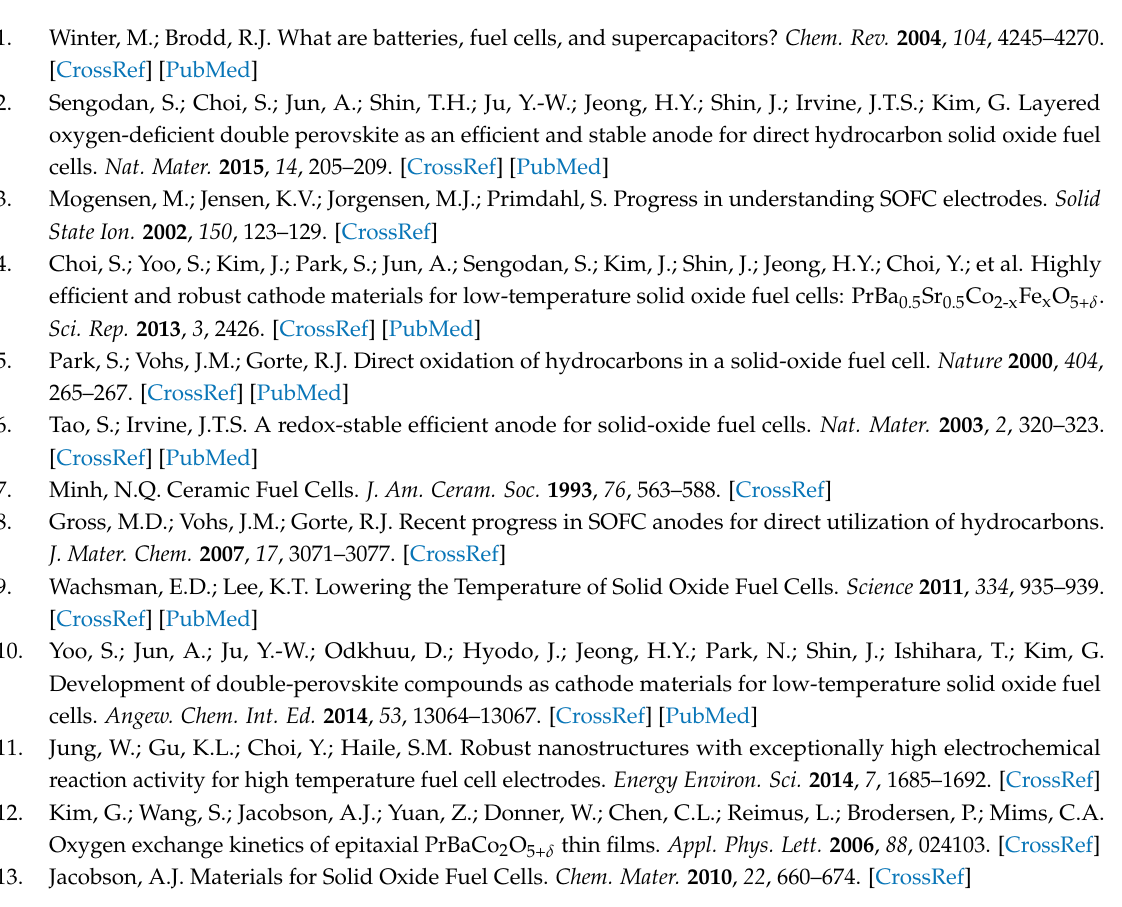
s1, Figure S1: The high-resolution transmission electron microscopy (HRTEM) images of (a) PBCO, (b) PBCSc, and (c) SP-PBCSc, Figure S2: Impedance spectra of single cells (Cathode/GDC/Ni-GDC) in a temperature range of 450 to 550 ◦ C: (a) PBCO, (b) PBCSc and (c) SP-PBCSc,